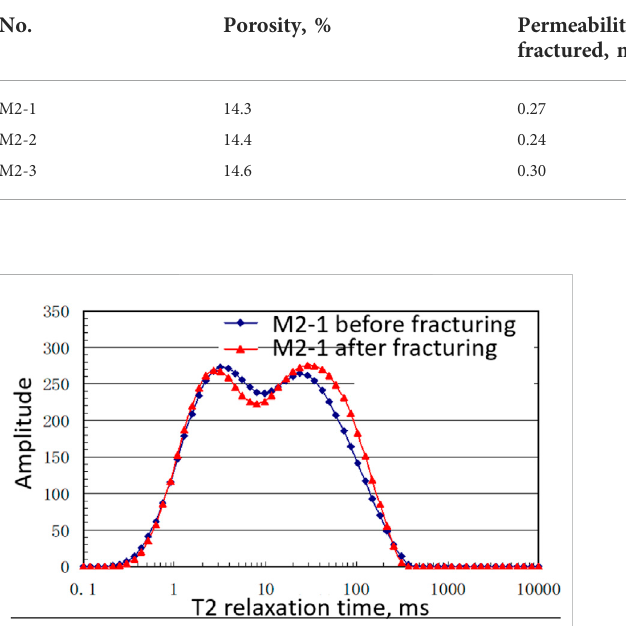
FIGURE 13 T2 spectral comparisons of slit cores before and after being